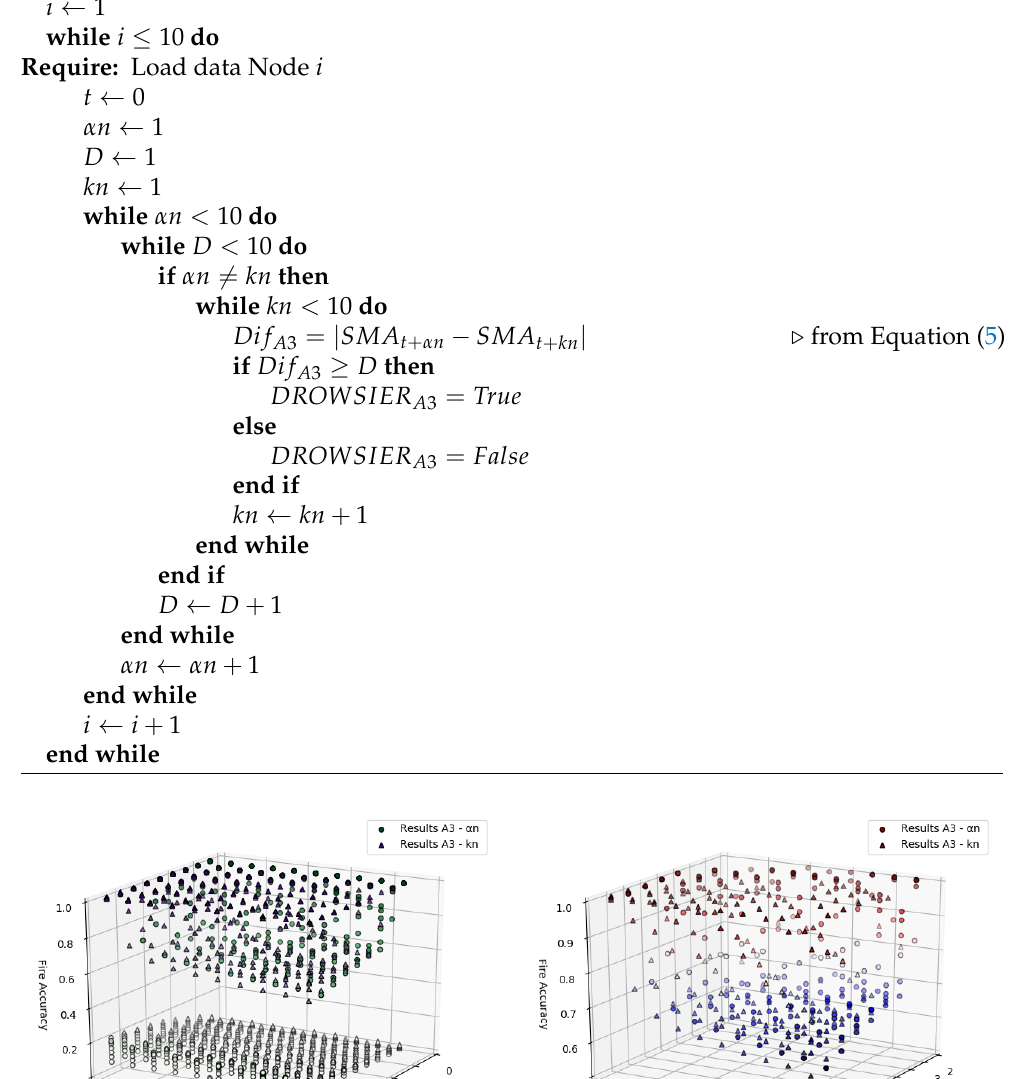
Algorithm 3 Pseudocode algorithm for testing the parameters of Differences between two SMAs algorithm— A 3.